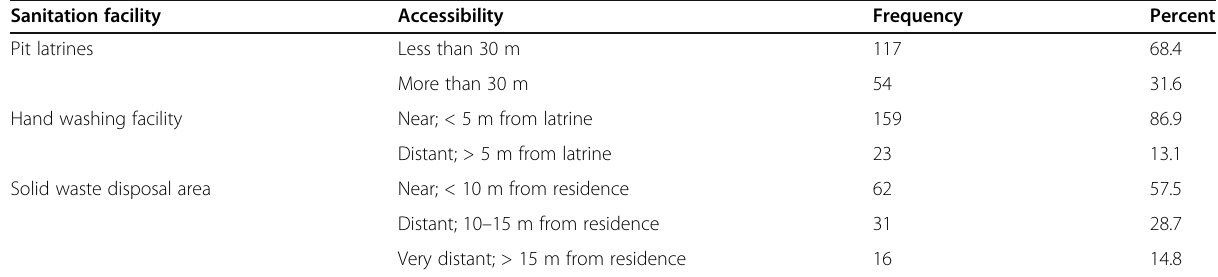
Table 1 Accessibility of sanitation facilities in Bidibidi refugee camp (researchers ’ questionnaire survey) Sanitation